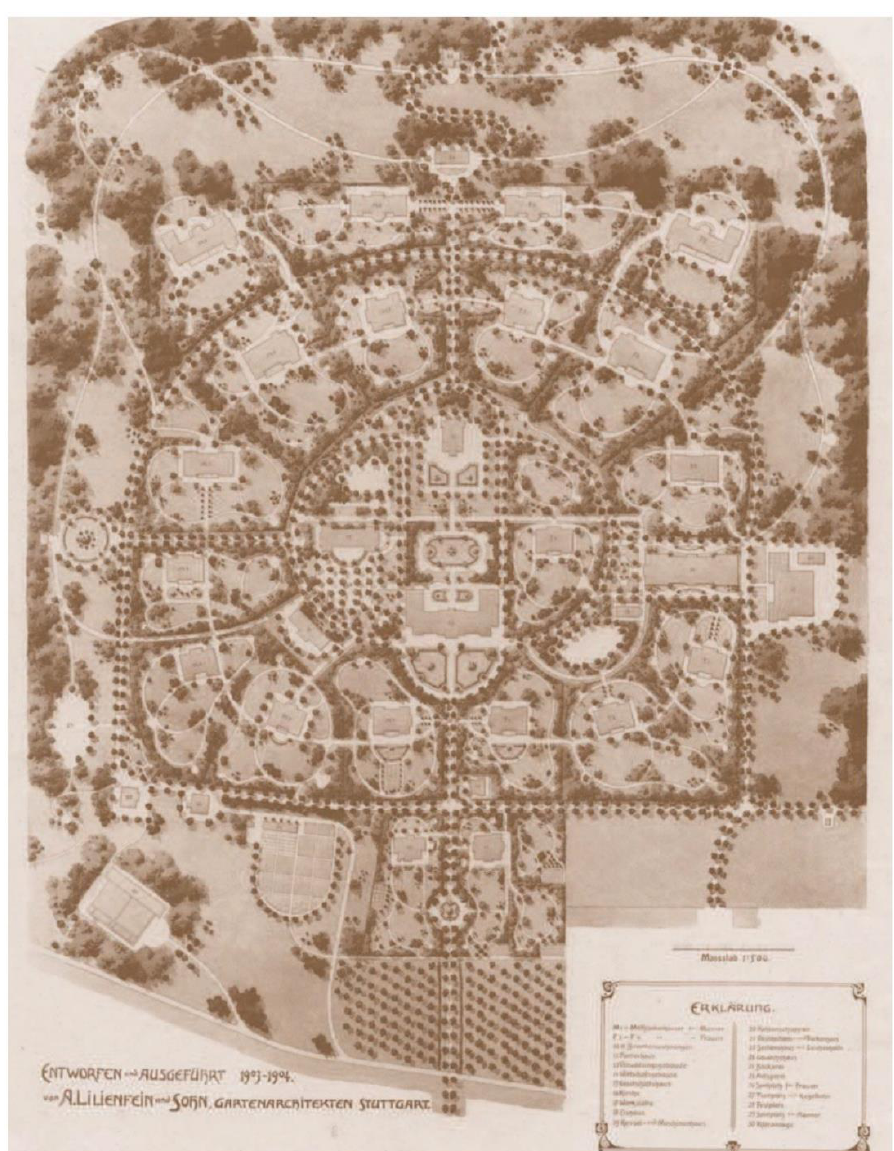
Figure 5. A plan of the park and gardens surrounding the institution in Weissenhof-Weinsberg, planned and implemented by A. Lilienfein and son, garden architects in Stuttgart from 1903–1904; source: courtesy of the archive of the Zentrum für Psychiatrie Weinsberg.